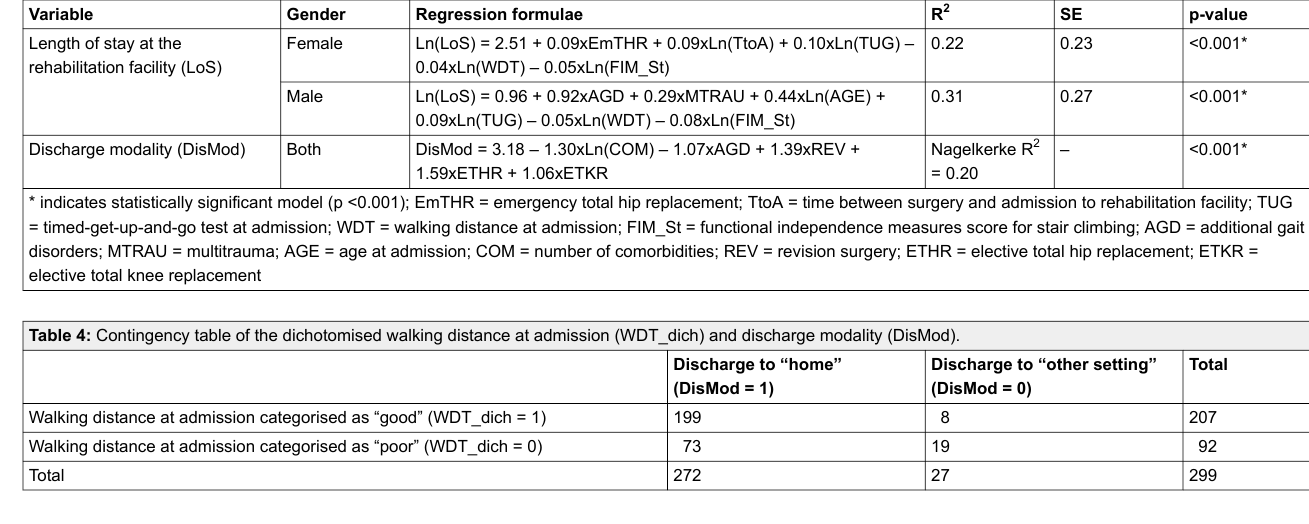
Table 3: Explorative regression formulae to predict length of stay (LoS) in female and male patients and discharge modality (DisMod) in both genders. Variable